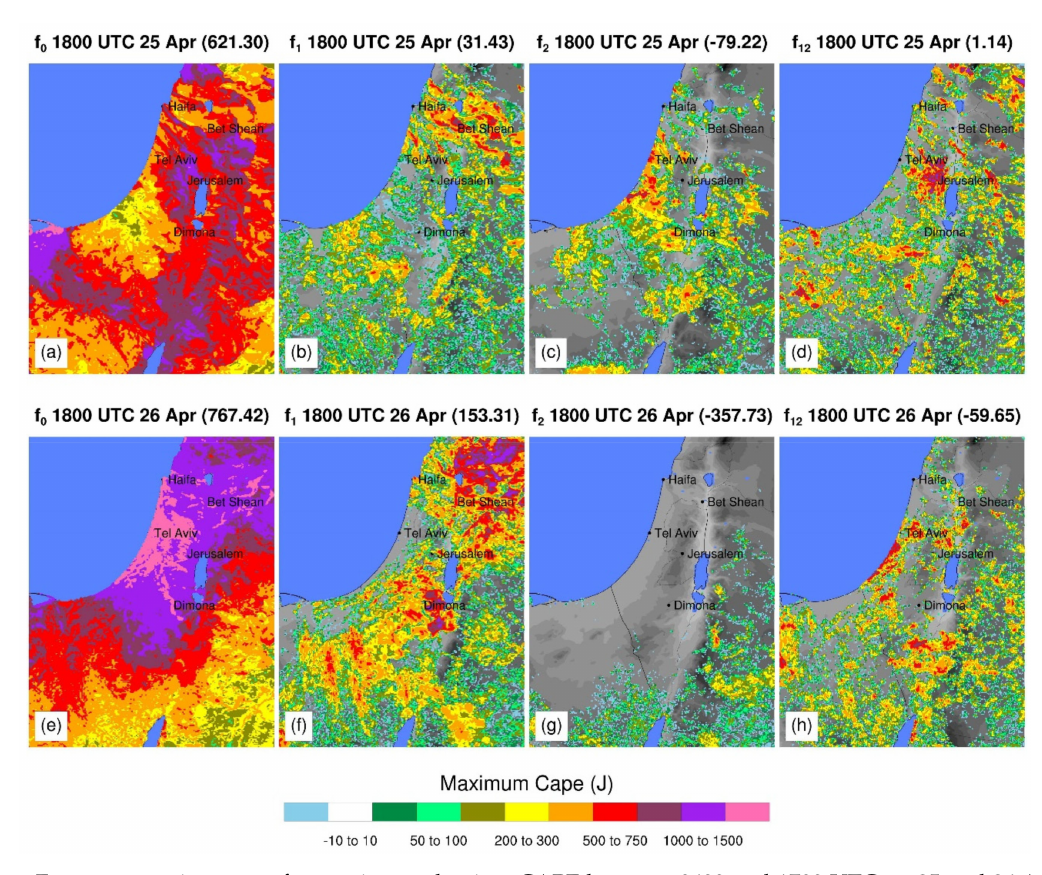
Figure 12. Factor separation maps for maximum daytime CAPE between 0600 and 1700 UTC on 25 and 26 April 2018. The factors were calculated for the 1.3 km (D03) simulation domain. The factor f o ( a , e ) is from the control simulation, while f 1 ( b , f ) represents the effect of local volumetric soil moisture (from S-2.0) on maximum CAPE values. The factor f 2 ( c , g ), represents the effect of non-local moisture sources on maximum CAPE values, while f 12 ( d , h ) shows the effect of coupled interactions of nonlocal and local moisture sources on maximum CAPE. The numbers within the parentheses show the average values of CAPE over